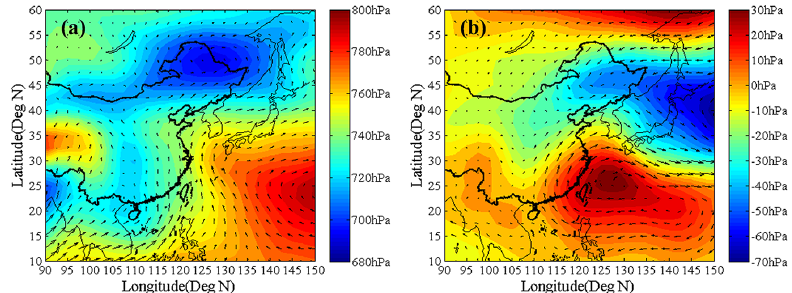
Figure 13. (a) Average geopotential height and wind vectors at the 925hPa level during August 2013. (b) Differences in geopotential height and wind vectors between August 2013 and August 2012 at the 925hPa